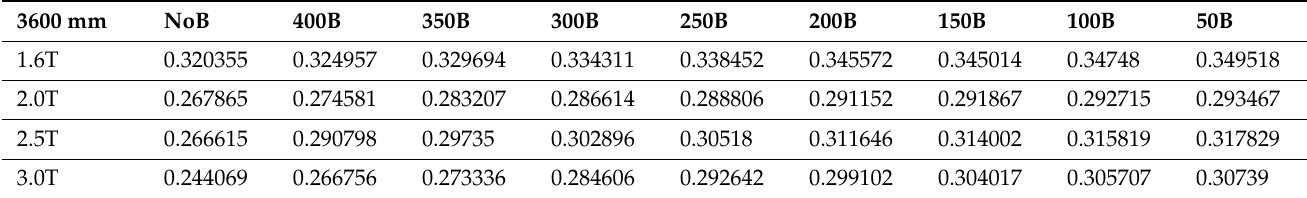
Figure 14. Normalised load-displacement diagrams of the FE results for: ( a ) 2400L-1.6T, ( b ) 2400L-2.0T, ( c ) 2400L-2.5T, and ( d ) 2400L-3.0T models. Table 1. Ultimate normalised compressive capacities for 3600 mm models based on reinforcement spacing.